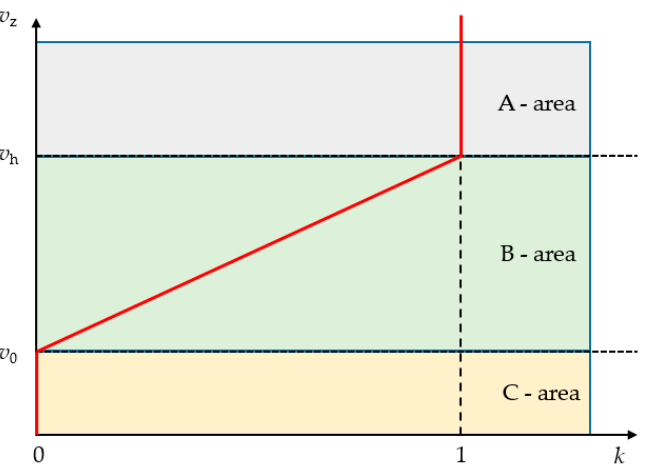
Figure 3. Relationship between the supply voltage v z and the scale factor k .